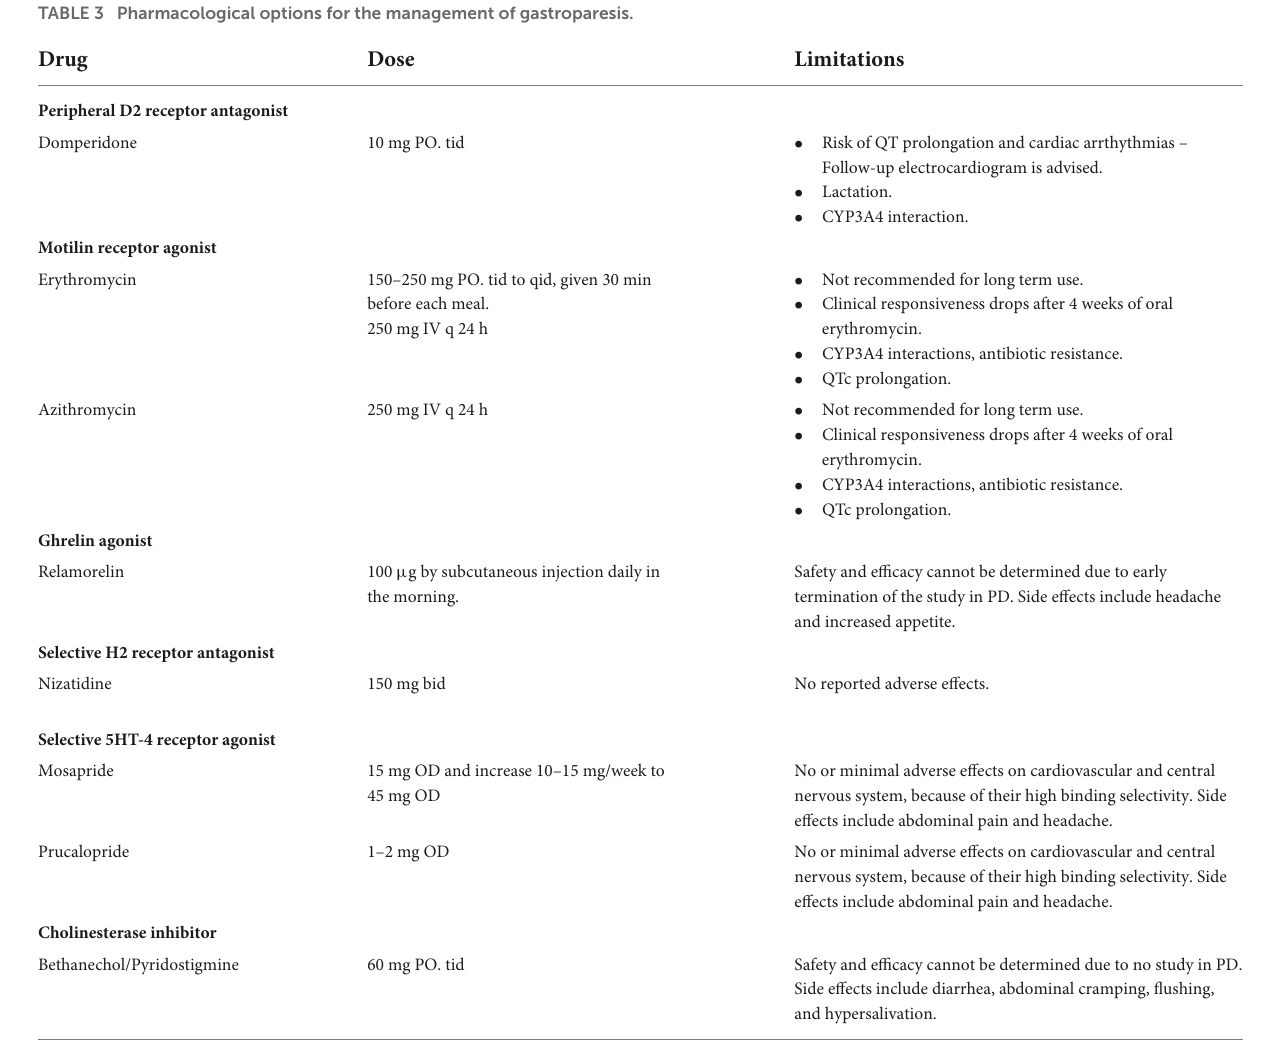
TABLE 3 Pharmacological options for the management of